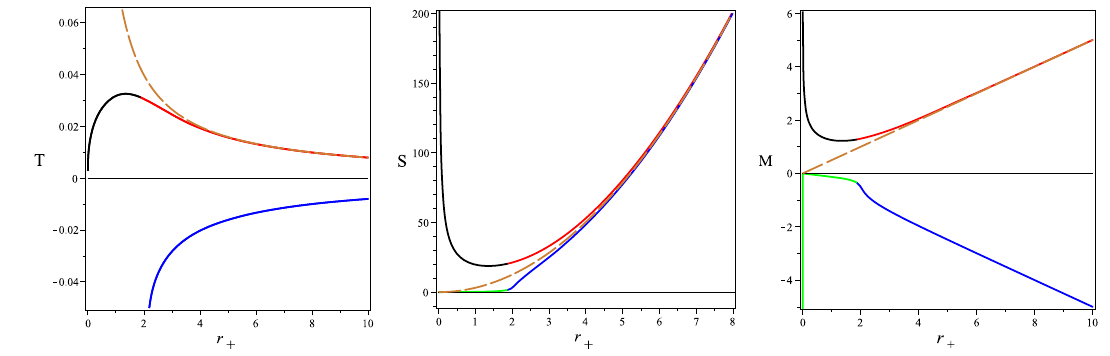
Fig. 1 The temperature, entropy and mass as a function of r + for c 1 = − 0 . 25 ,α = 0 . 5. The orange long dashed lines related to the Schwarzschild’s black hole